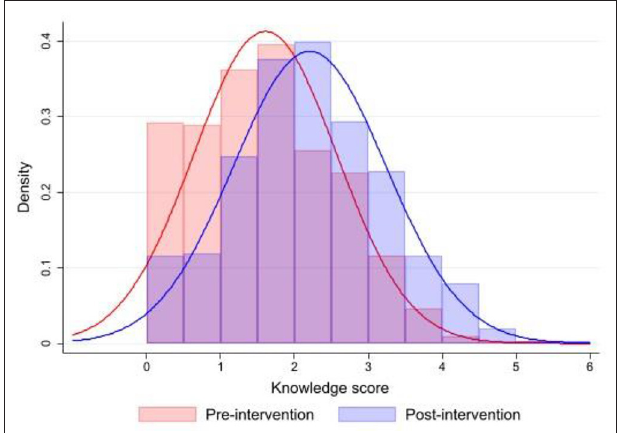
FIGURE 2 | Histograms of pre-intervention ( N = 602; April 2020) and post-intervention ( N = 606; December 2020) vitamin D-related knowledge in the study sample. The horizontal (x) scale uses the vitamin D-related knowledge score units, while the respondent’s knowledge distribution is represented by the vertical bars (Red color line depicts normal Gaussian distribution of pre-intervention knowledge score, while blue color line depicts normal Gaussian distribution of post-intervention knowledge score).